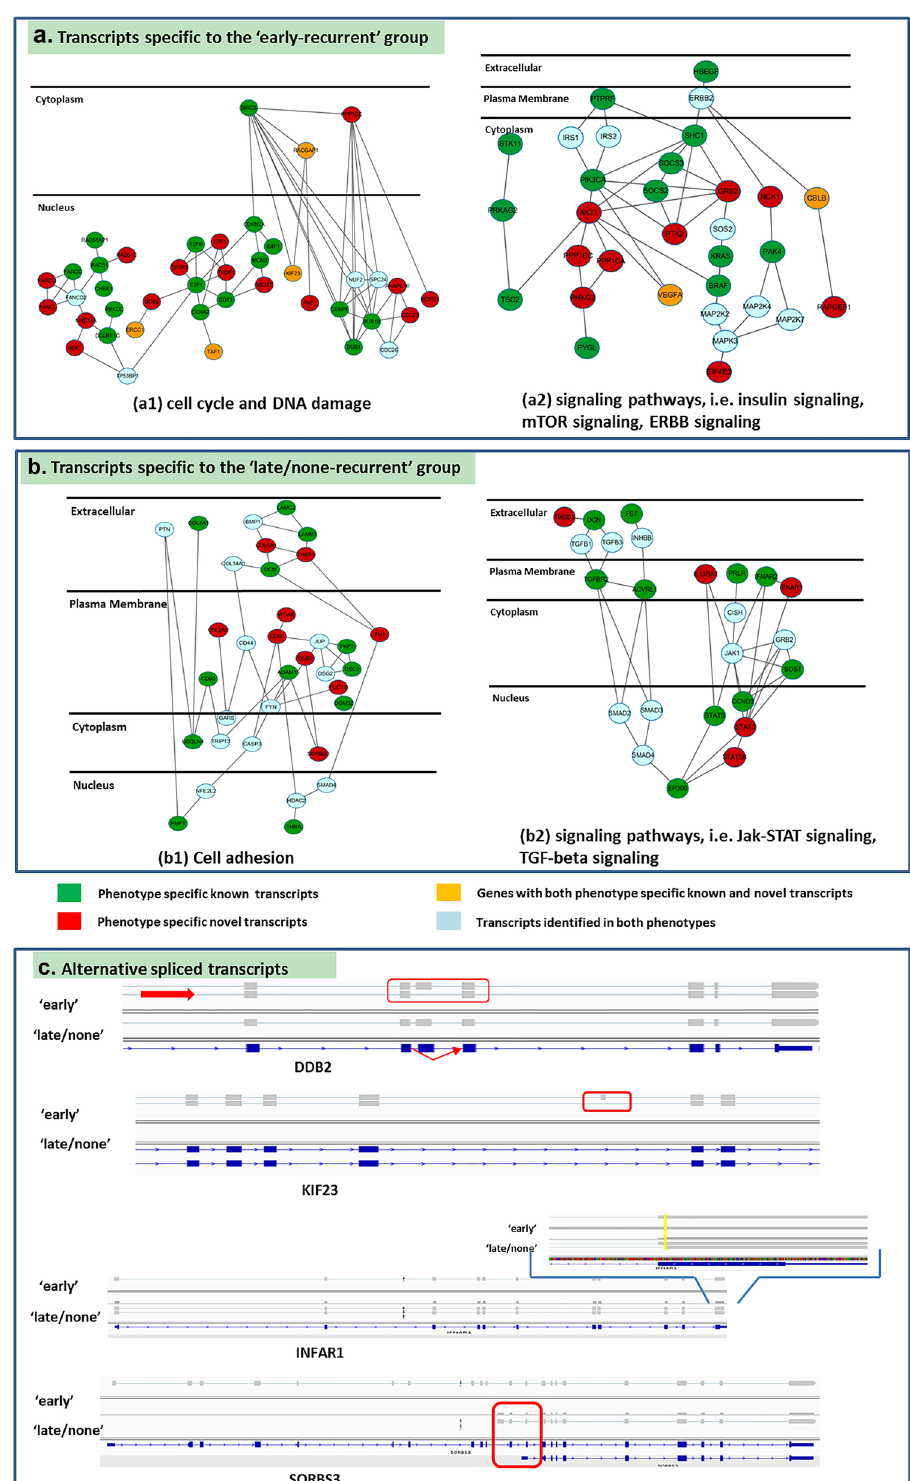
Figure 4. Phenotype-specific transcripts assembled by BayesDenovo: (a) transcripts specific to the ‘early- recurrence’ group enriched in cell cycle, DNA damage and signaling pathways; (b) transcripts specific to the ‘late/none-recurrence’ group enriched in cell adhesion and signaling pathways. (c) Examples of novel alternative spliced